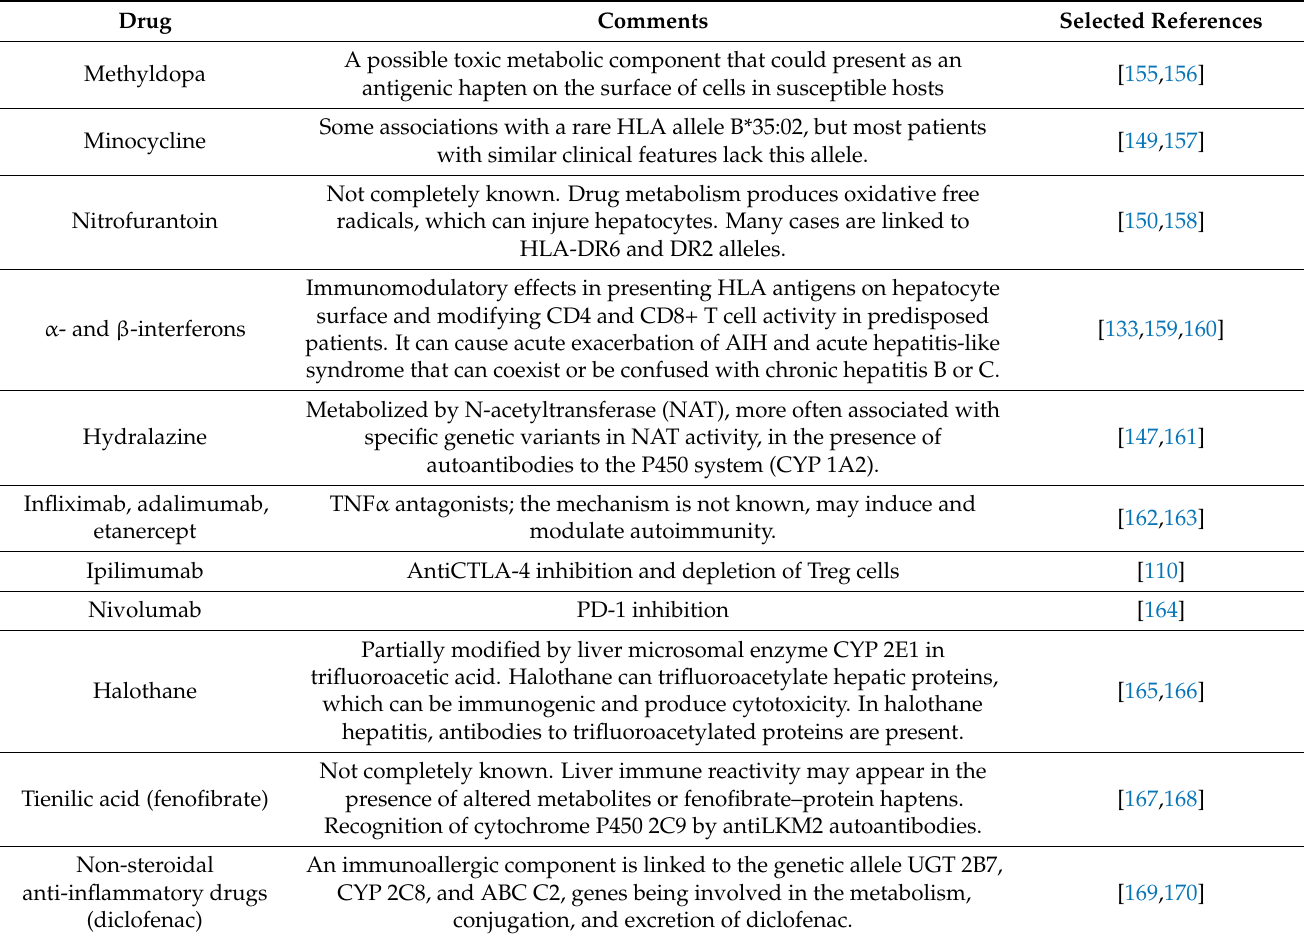
Table 2. Drugs associated with the induction of